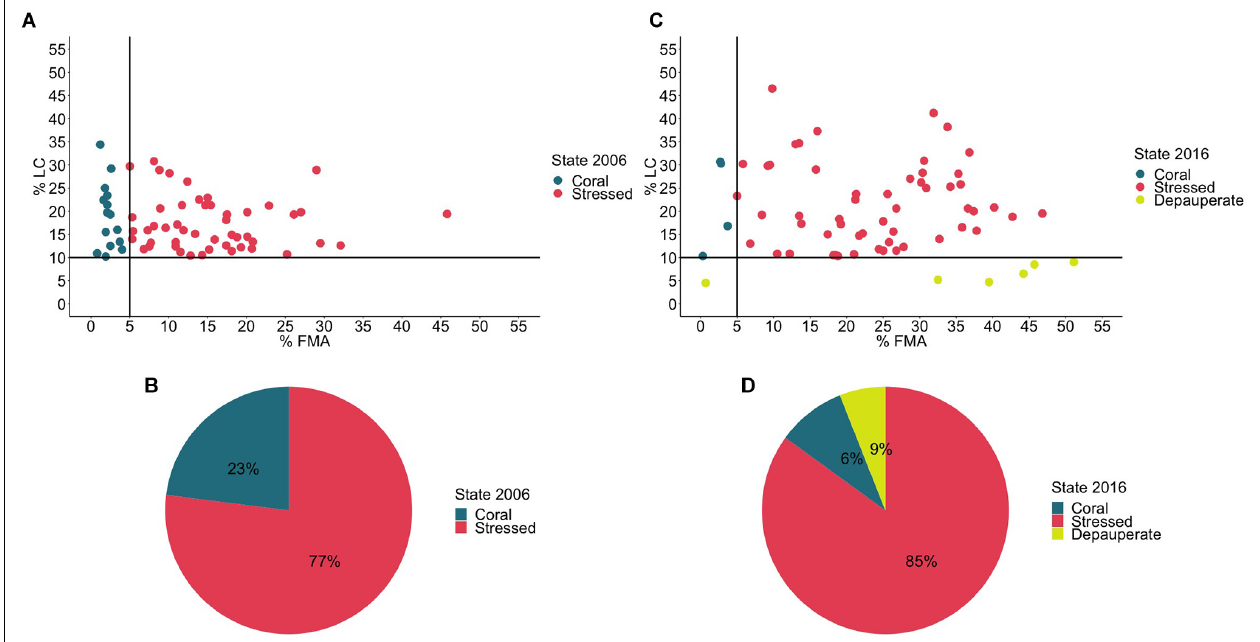
FIGURE 3 | (A) Coral State in 2006 as a function of live coral (% LC) and fleshy macroalgae (% FMA) covers (top left). Sites in a coral state are in green and sites in a stressed coral state are in red. (B) Percentage of sites in a coral state and a stressed coral state in 2006 (bottom left). (C) Coral State in 2016 as a function of live coral (% LC) and fleshy macroalgae (% FMA) covers (top right). Sites in a coral state are in green, sites in a stressed coral state are in red and sites in a depauperate coral state are in yellow. (D) Percentage of sites in a coral state, a stressed coral state and a depauperate coral state in 2016 (bottom